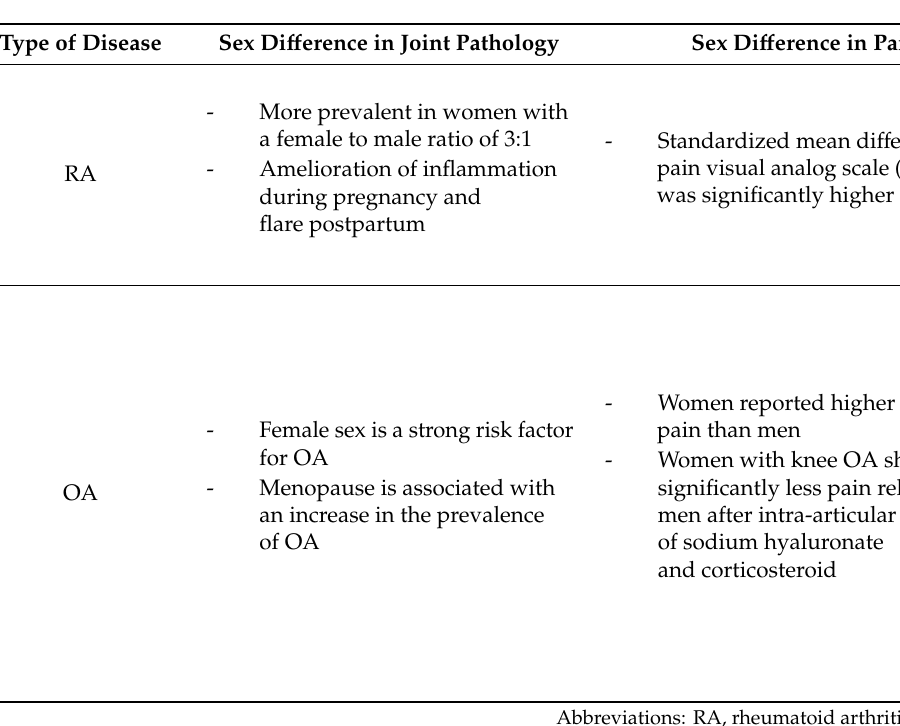
Table 1. Sex di ff erence in human arthritis and